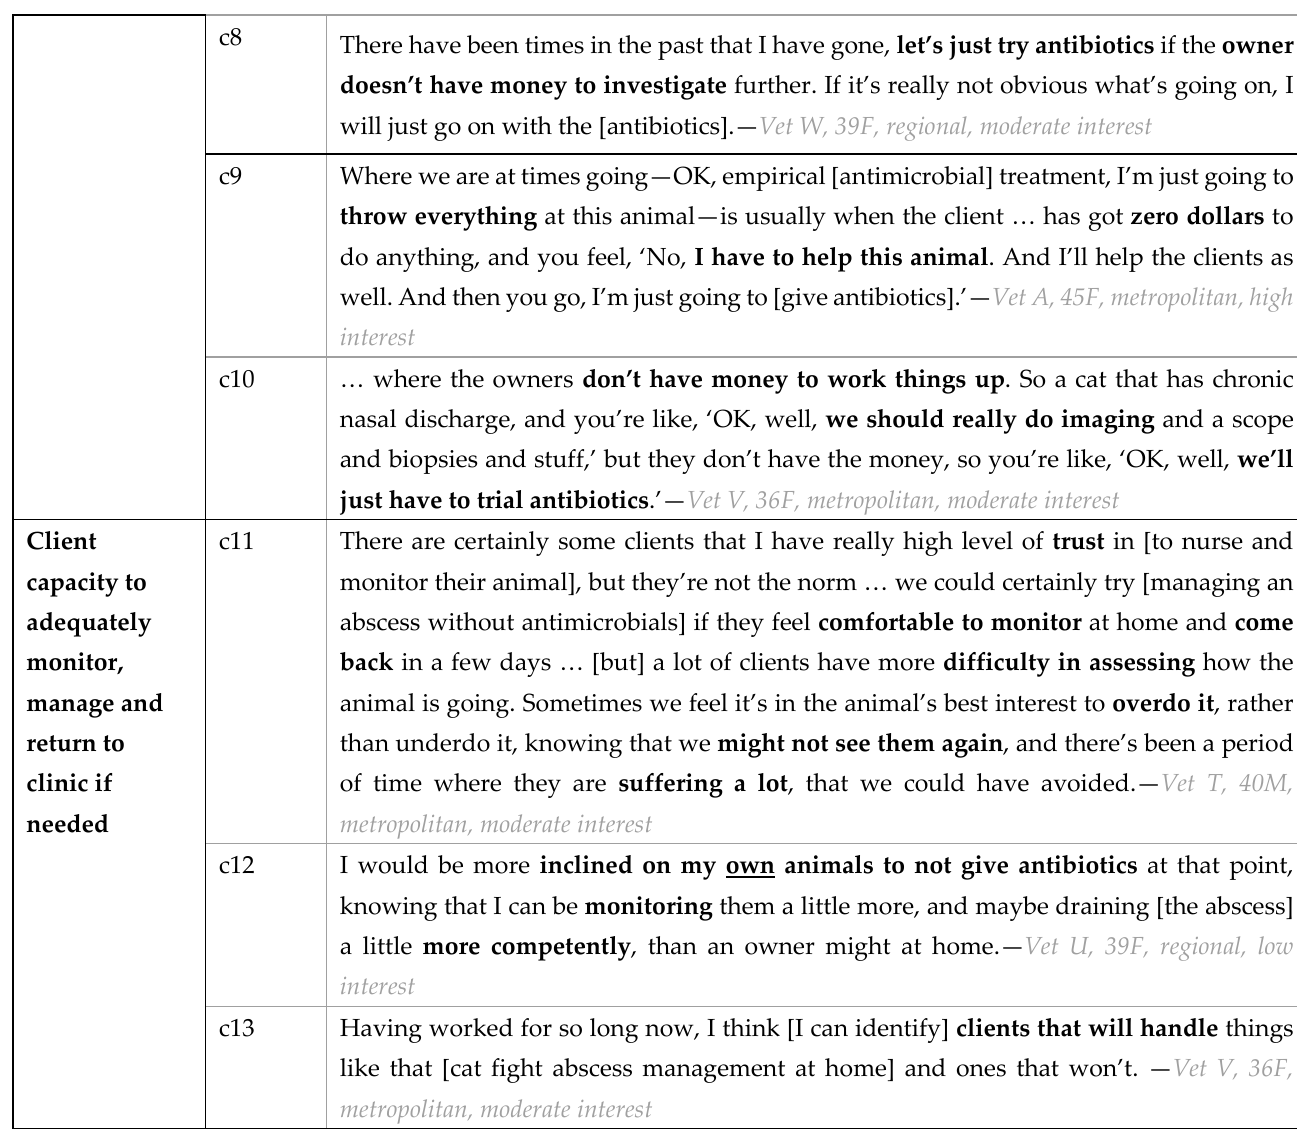
Figure 7. Control beliefs influencing decision to withhold or delay antimicrobial treatment where there is no clear indication, and illustrative quotes. Bold text has been used to highlight key ideas. Grey italics have been used for participant code, age and gender, location of practice and level of interest in AMR and AMS.